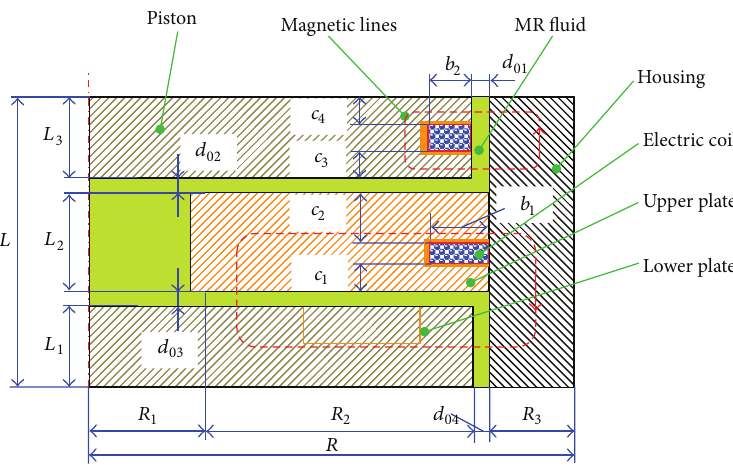
Figure 25: Section of MR valve for damper-mount